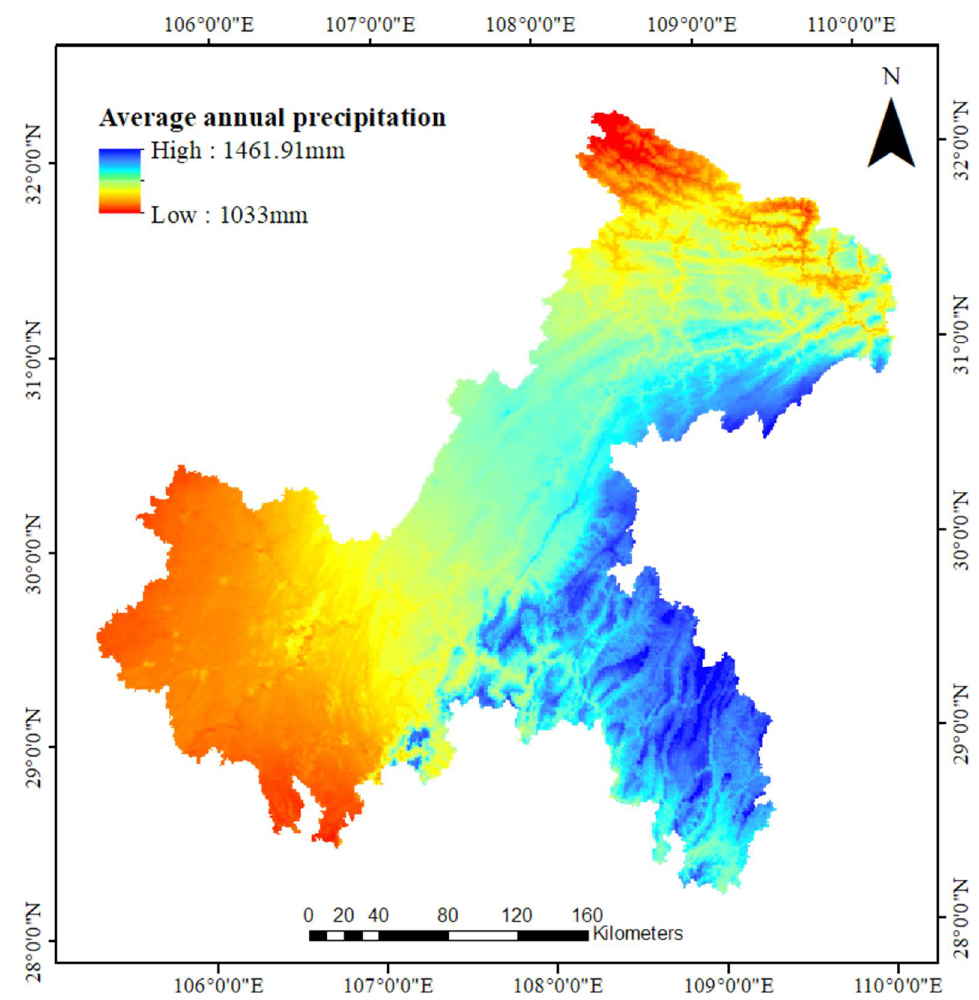
Figure A2. Spatial distribution of annual average precipitation in Chongqing from 2000 to 2020.